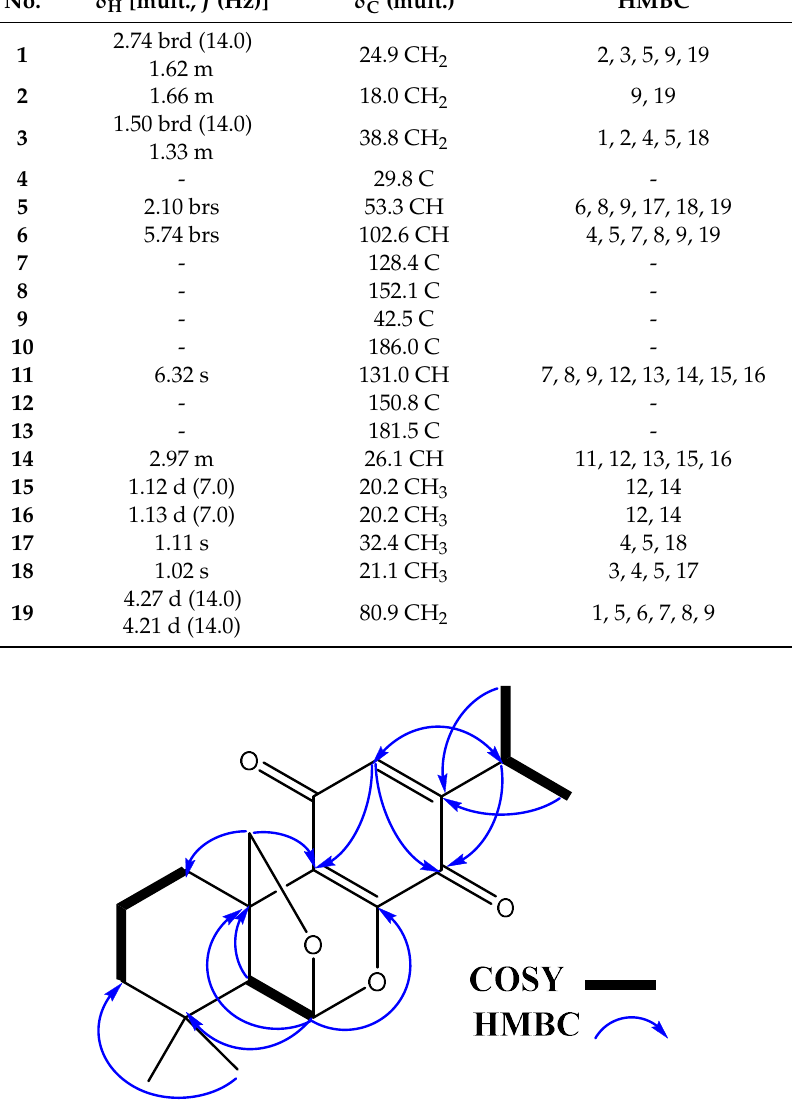
Figure 2. Some Key 1 H- 1 H COSY and HMBC correlations of 2 .